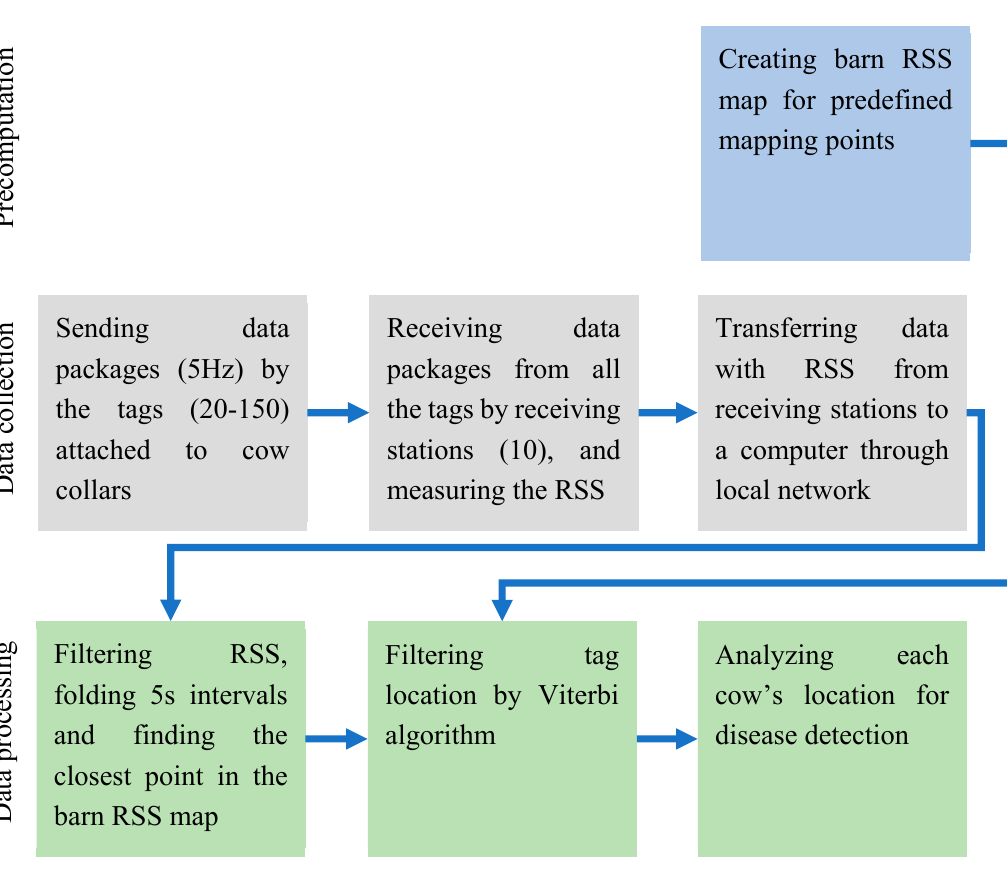
Figure 3. Cow localization flow chart.